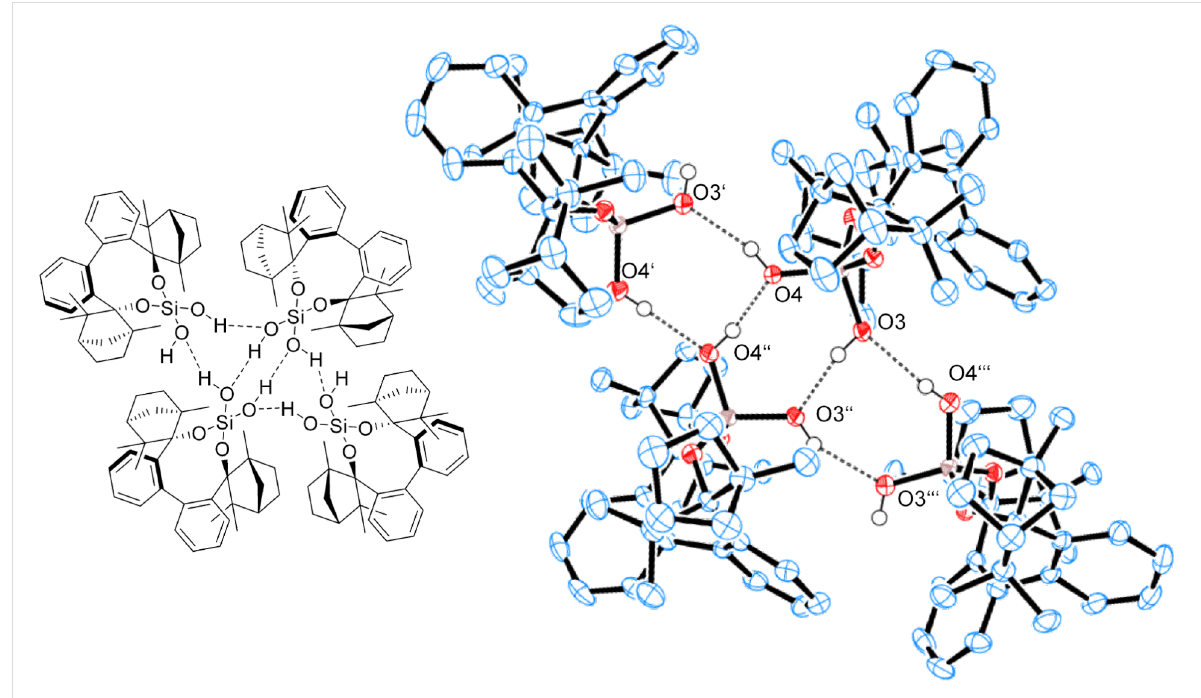
Figure 15: X-ray crystal structure of BIFOXSi(OH) 2 ( 9 ) forming a tetramer. H atoms on the chiral backbone are omitted for clarity issues and the ellip- soids are shown with 65% probability. For bond lengths and angles see Table 5.